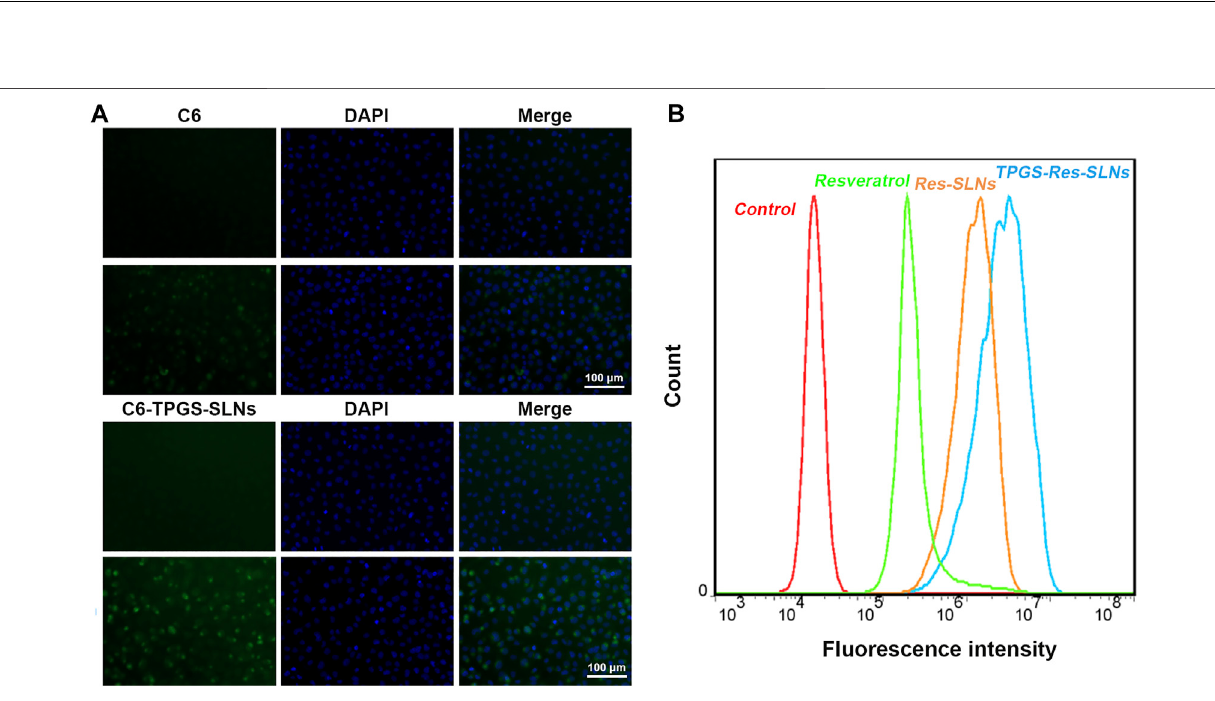
Frontiers in Bioengineering and Biotechnology |